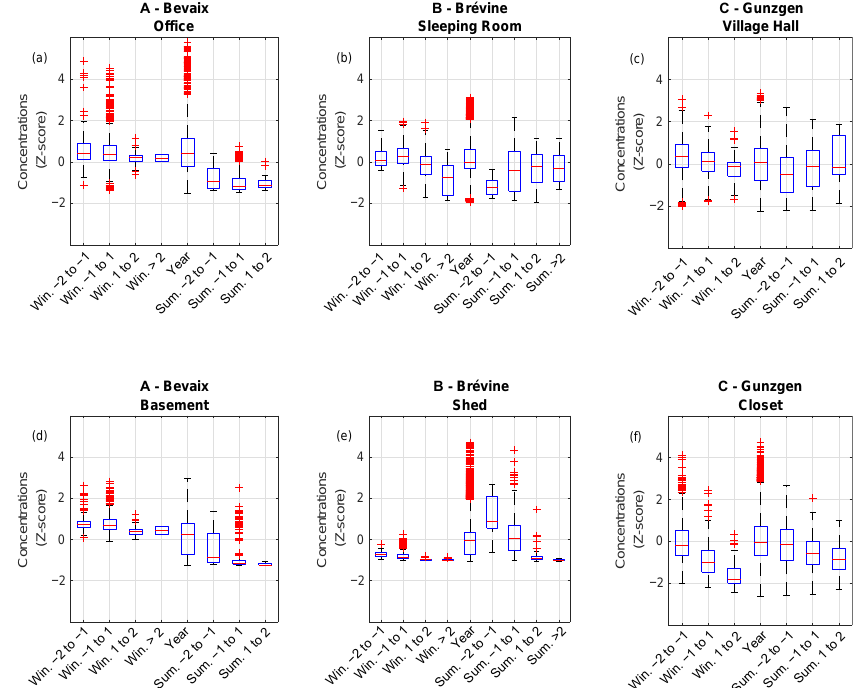
Figure 6. Box-plots synthesizing the impacts of easterly winds on IRC at Bevaix ( a , d ), La Brévine ( b , e ), and Gunzgen ( c , f ). Occupied spaces are shown in ( a – c ) and unoccupied spaces in ( d – f ). Annual standard deviation threshold results are given for both winter and summer. Some of them are missing because they did not occur.